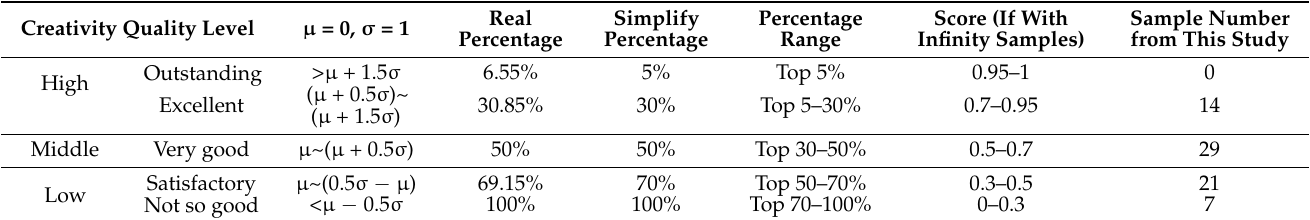
Table 4. The division index for creativity quality levels.